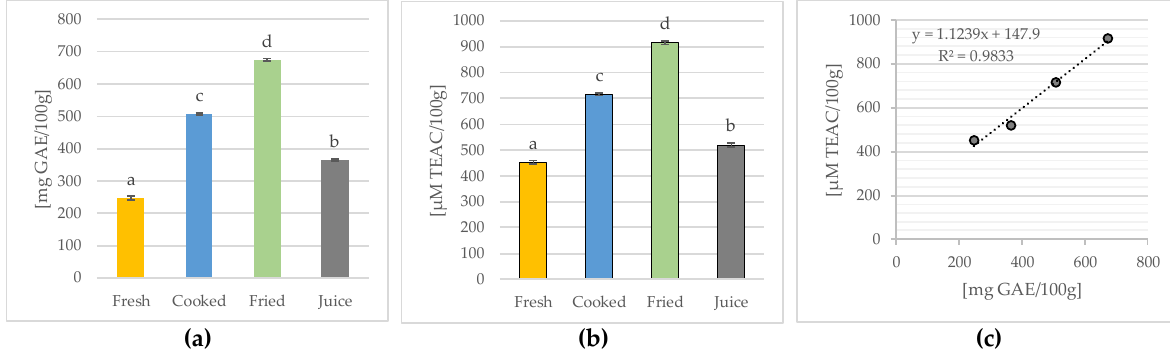
Figure 4. Total polyphenol content ( a ), antioxidant potential ( b ), and relation between total polyphenol content (mg GAE/100 g) and antioxidant potential (µM TEAC/100 g) ( c ) in fresh quince fruit and its products. Mean values ( n = 3) marked in bars by different letters differ significantly (Duncan’s test, p ≤ 0.05). GAE—Gallic Acid Equivalent, TEAC—Trolox Equivalent Antioxidant Capacity. Fresh quince fruits were characterized by a high content of total polyphenols (246.98